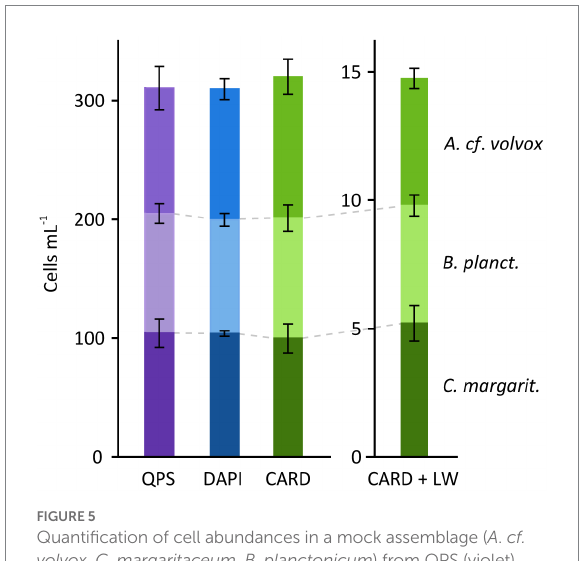
FIGURE 5 Quantification of cell abundances in a mock assemblage ( A . cf. volvox , C. margaritaceum , B. planctonicum ) from QPS (violet), DAPI-stained (blue) and hybridized cells (CARD-FISH, green). Each species was hybridized with its species-specific probe (Tables 1,2). CARD-FISH was additionally performed with the same mock assemblage mixed with lake water (CARD + LW). Error bars show standard